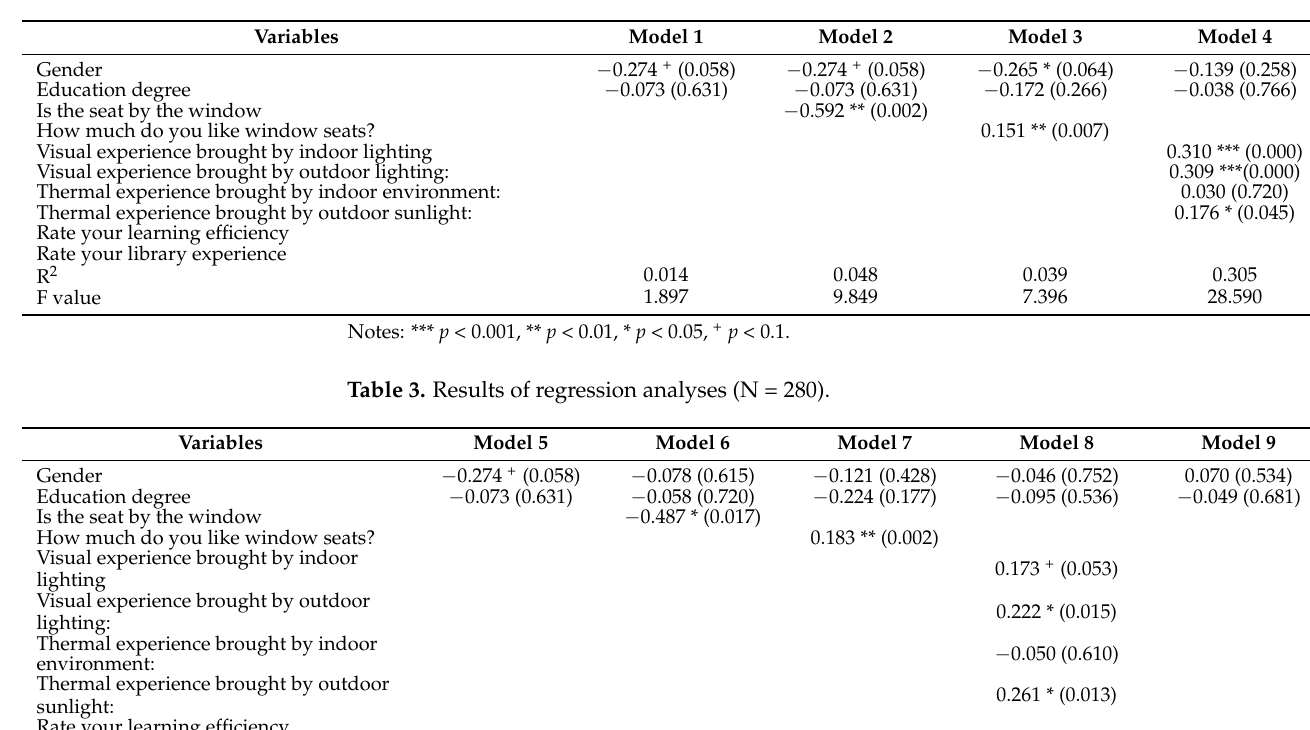
Table 2. Results of regression analyses (N = 280).